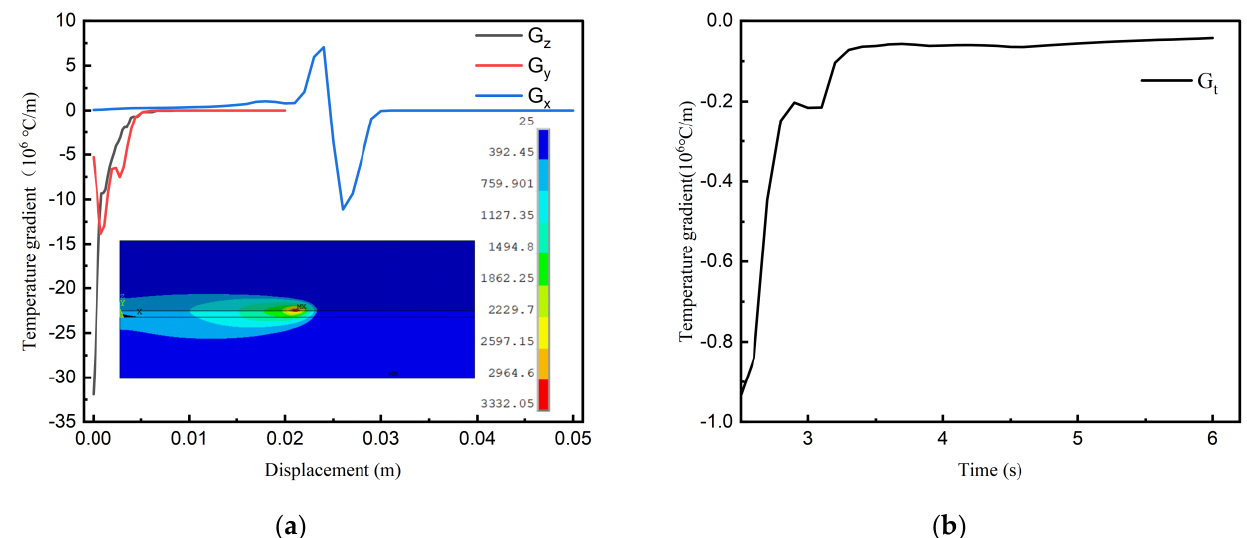
Figure 3. Temperature gradient curve: ( a ) temperature gradient curves in different directions and ( b ) transient temperature gradient.